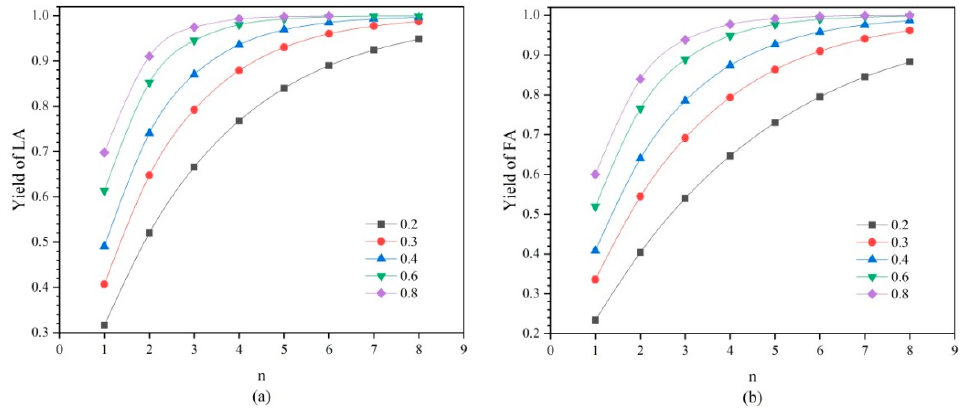
Figure 14. Influence of single-stage n-octanol dosage on yield of ( a ) LA and ( b ) FA.